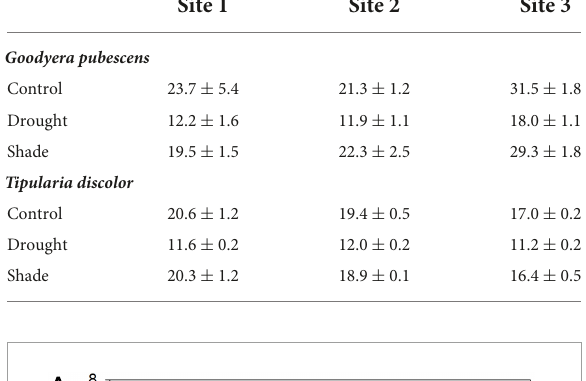
TABLE 1 Percent soil moisture (volumetric ± se) at each of the three sites and three treatments (control, drought, and shade) for Goodyera pubescens and Tipularia discolor .